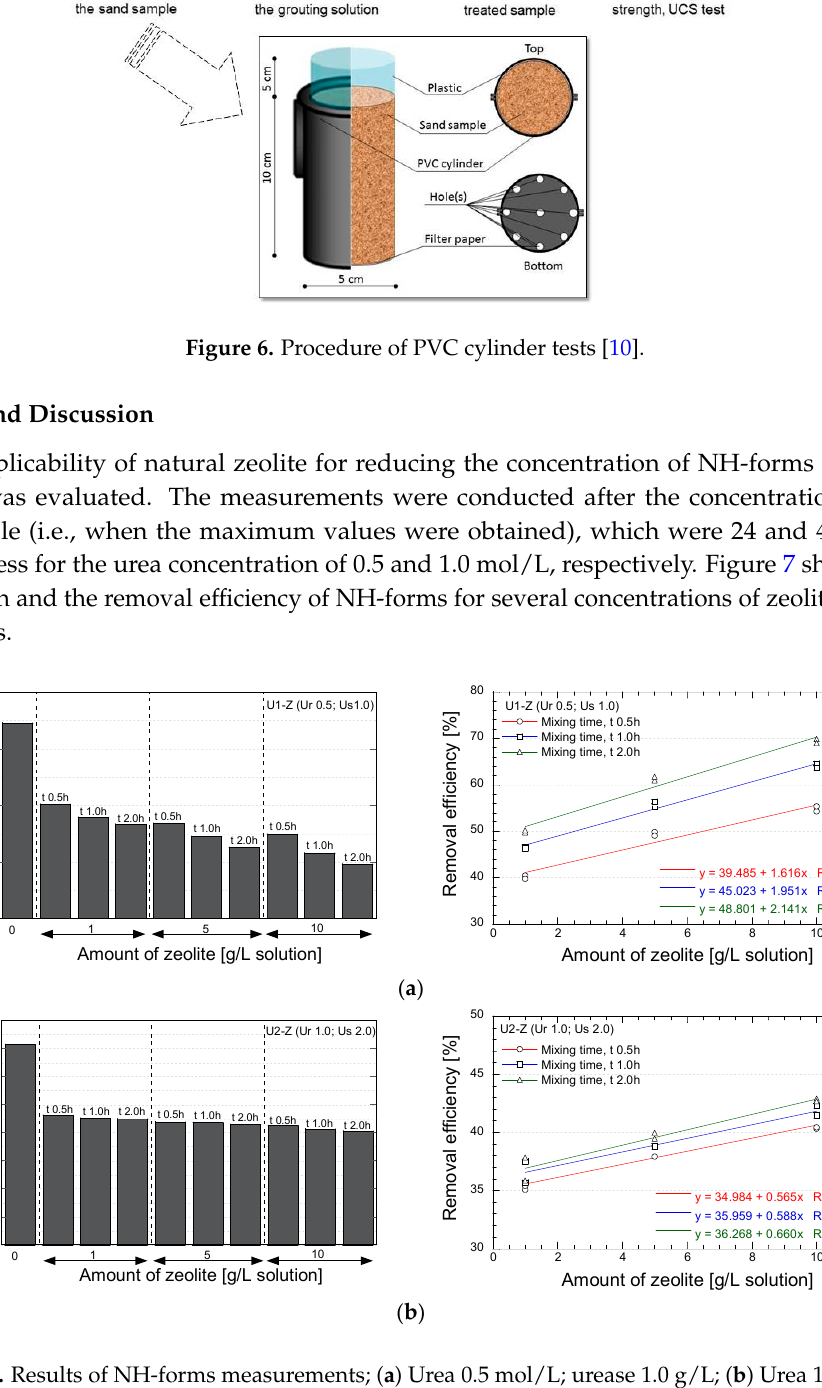
Figure 7. Results of NH-forms measurements; ( a ) Urea 0.5 mol/L; urease 1.0 g/L; ( b ) Urea 1.0 mol/L; urease 2.0